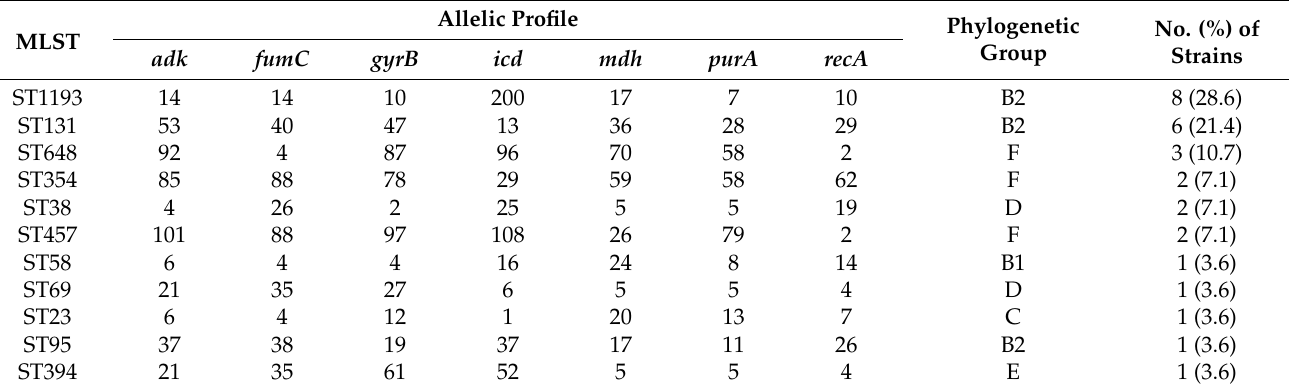
Table 1. Distribution of ST types and phylogenetic groups among the 28 E. coli isolates.